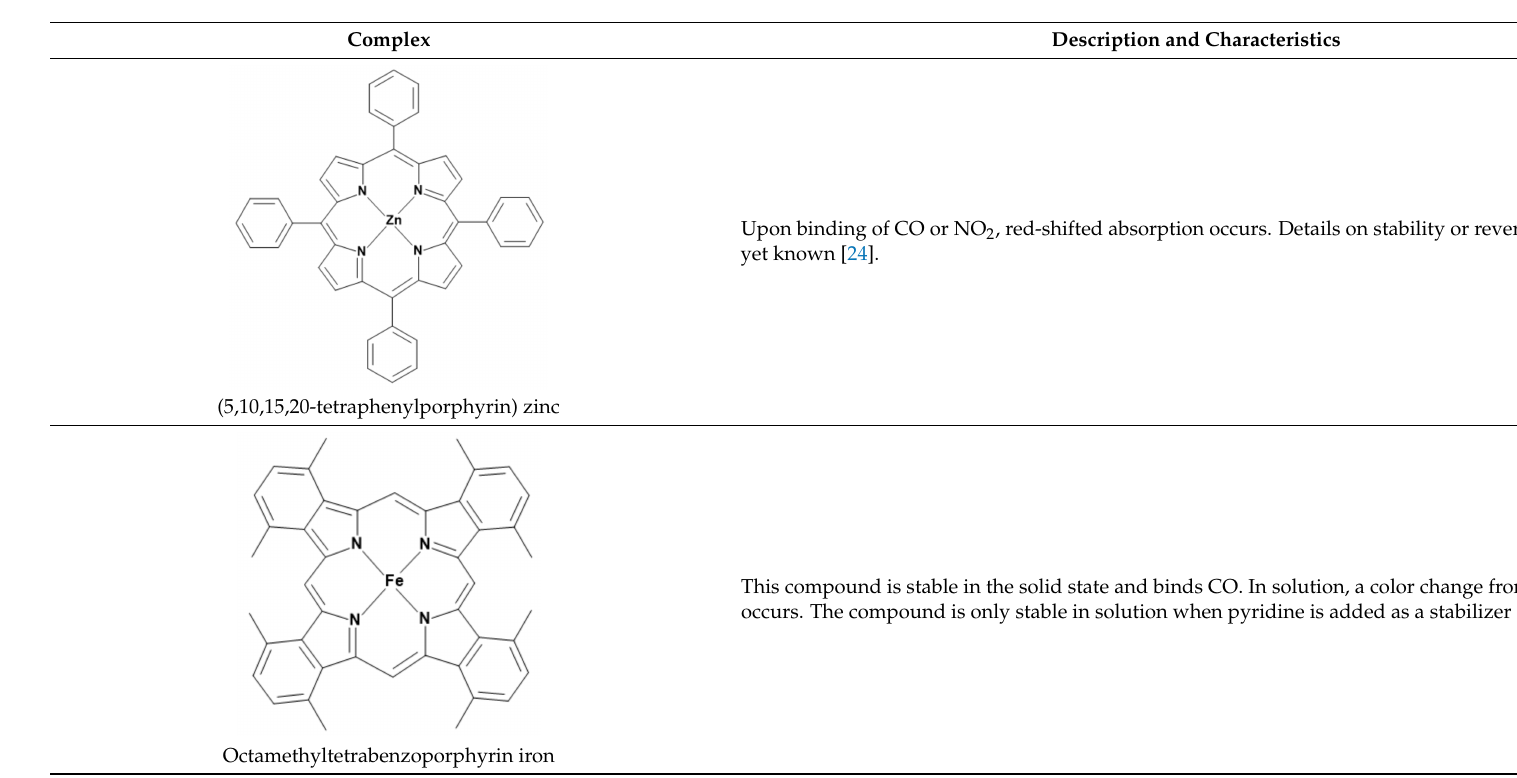
Table 1. Metal complexes for the detection of